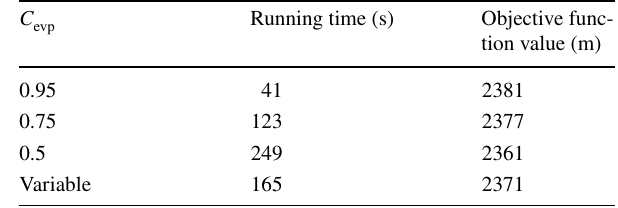
Table 4 Results of optimization for various values of C evp in 500